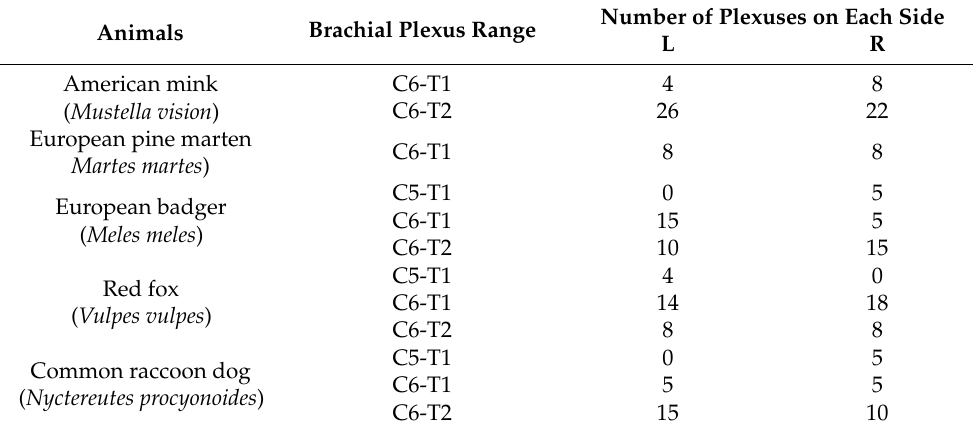
Table 1. The range of the brachial plexus in species examined (the numbers indicated refer to the number of plexuses ( p ) examined in each species). Number of Plexuses on Each Animals Brachial Plexus Range